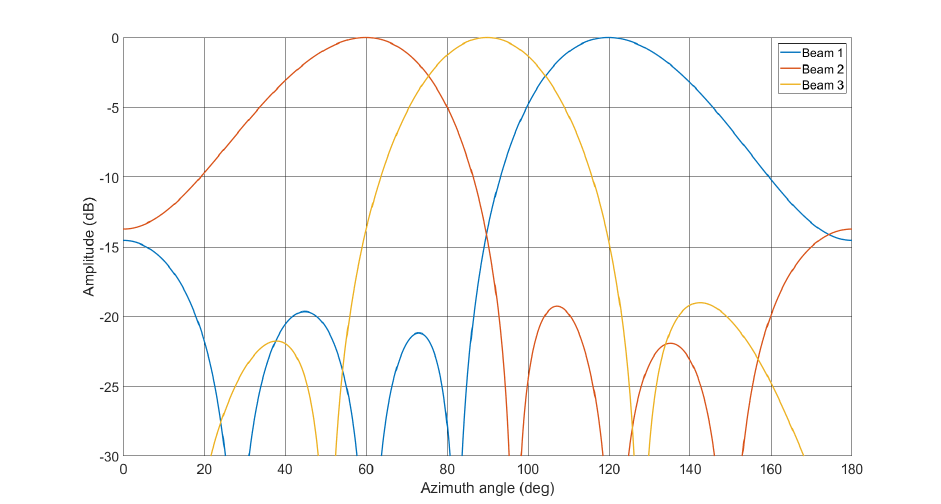
Figure 31. Calculated array factor of the tree